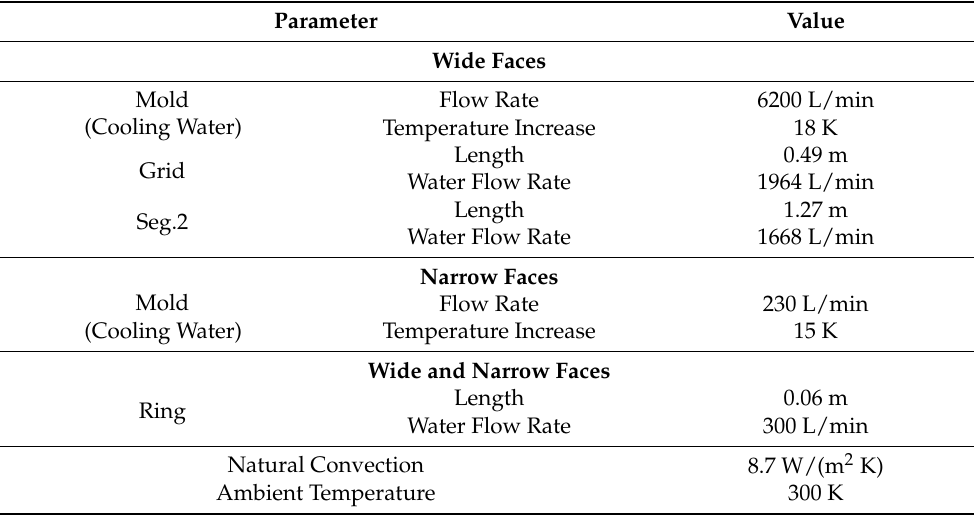
Table 2. Key parameters for calculating the heat flux profile on wide and narrow faces.